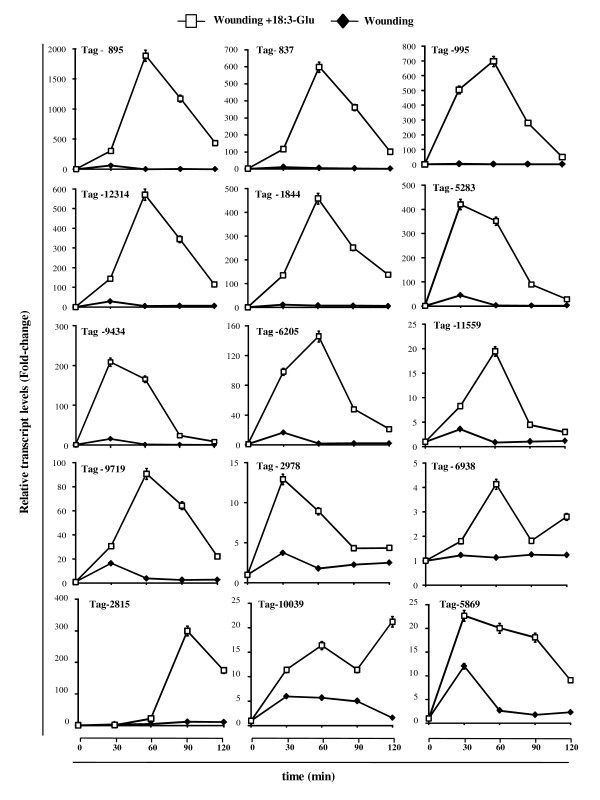
Analysis of mRNA accumulation corresponding to selected UniTags by qPCR. Examples of the kinetics of induction of mRNAs for 15 UniTags analyzed by qPCR after wounding and 18:3-Glu elicitation. Relative mRNA quantification was performed using the eEF1A as a reference gene for normalization and the data is expressed as fold-change relative to time 0 (unelicited leaves). Values at this time point were set arbitrary to 1. Transcripts levels were analyzed in three biological replicates (n = 3).